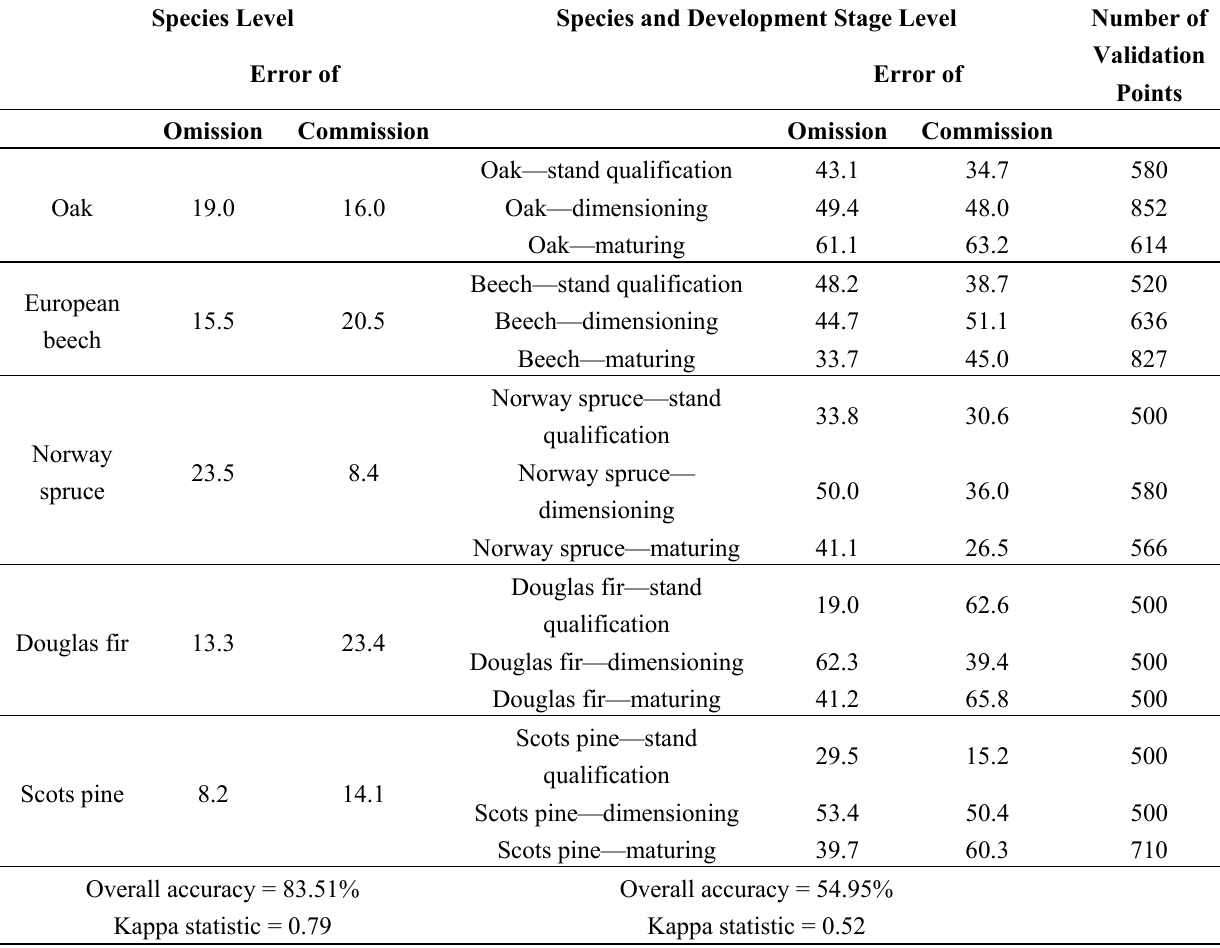
Table 4. Summary of classification accuracy for Rhineland-Palatinate